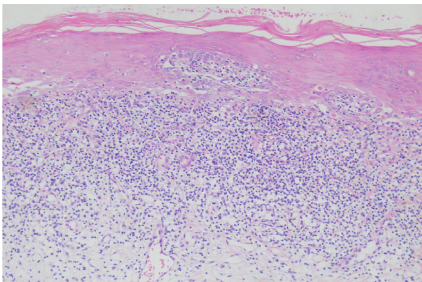
Figure 1: Lichenoid tissue reaction. Histopathologic examination shows a thickened surface layer of parakeratin, hydropic degeneration, apoptotic keratinocytes, and dense band-like inflammatory cell infiltrate in the superficial lamina propria. (H and E stain, Magnification x100). H and E; hematoxylin and eosin.